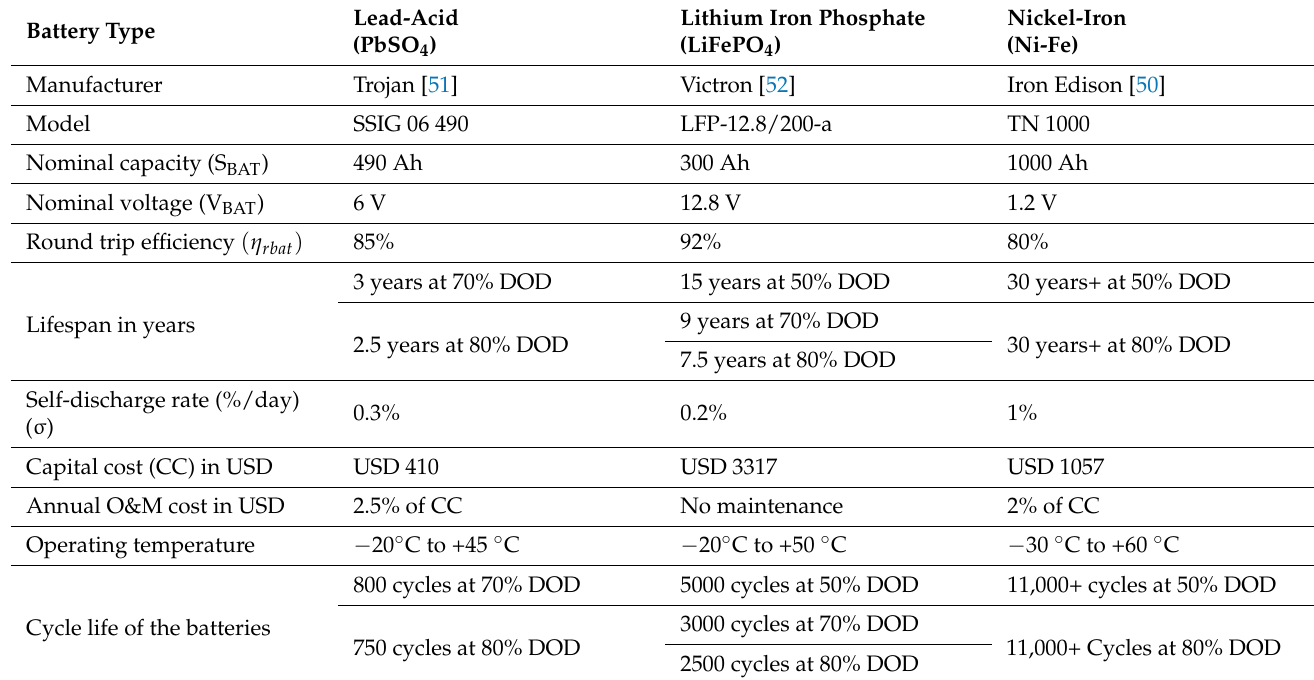
Table 5. Batteries’ techno-economic parameters and their values.